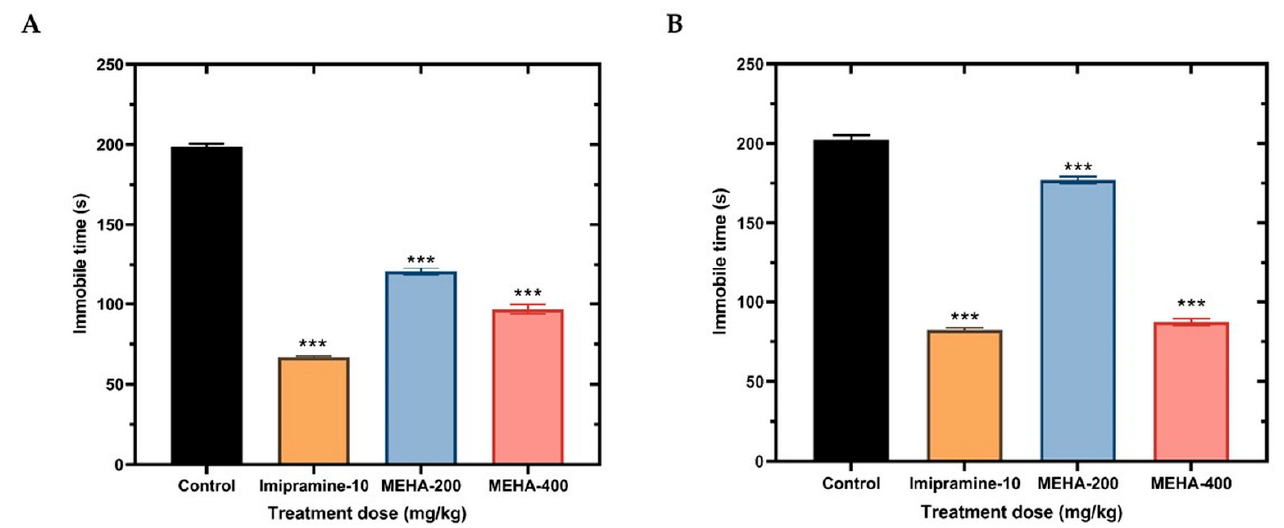
Figure 5. Antidepressant activity of MEHA on tail suspension ( A ) and forced swimming ( B ) tests in mice. Results are expressed in mean ± SEM. *** p < 0.001, significantly different from control; ANOVA followed by Dunnett’s test ( n = 3, per group). MEHA: methanol extract of Homalomena aromatica leaves; MEHA-200, methanol extract of H . aromatica 200 mg/kg; MEHA-400, methanol extract of H . aromatica 400 mg/kg; Reference drug imipramine hydrochloride (10 mg/kg).